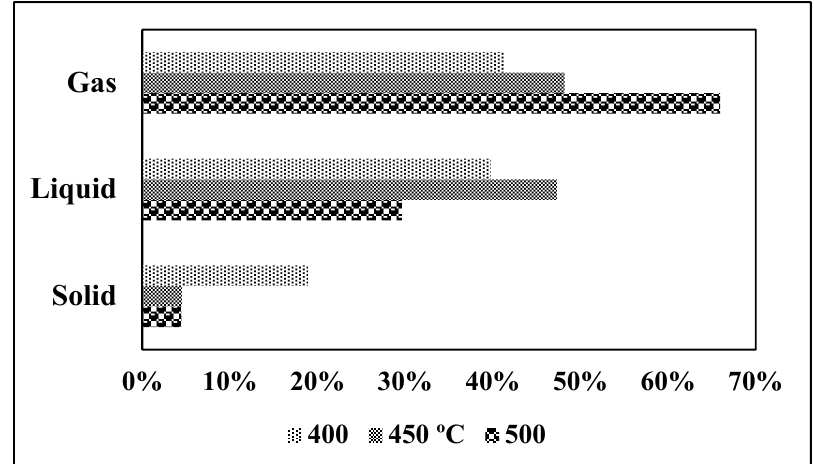
Figure 5. Influence of the NiFe 2 O catalyst loading on the carbon balance of supercritical water gasification (SCWG) of eucalyptus wood chips at 450 °C.